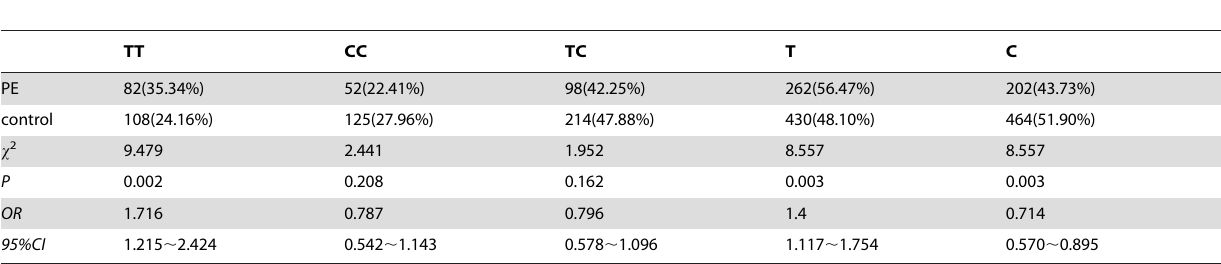
Table 3. Distribution the allele frequency and PE susceptibility of the IL-1 b -511T/C polymorphism between case and control groups.